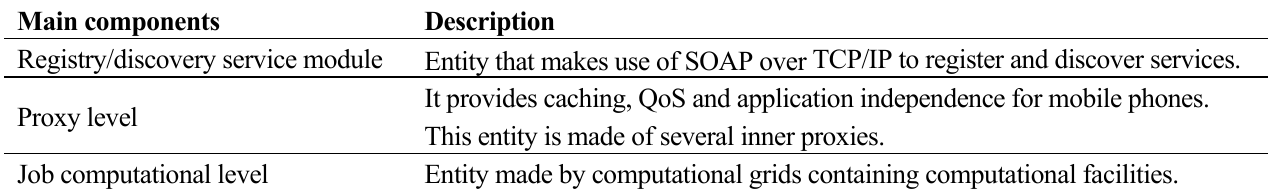
Table 11. Description of Signal main